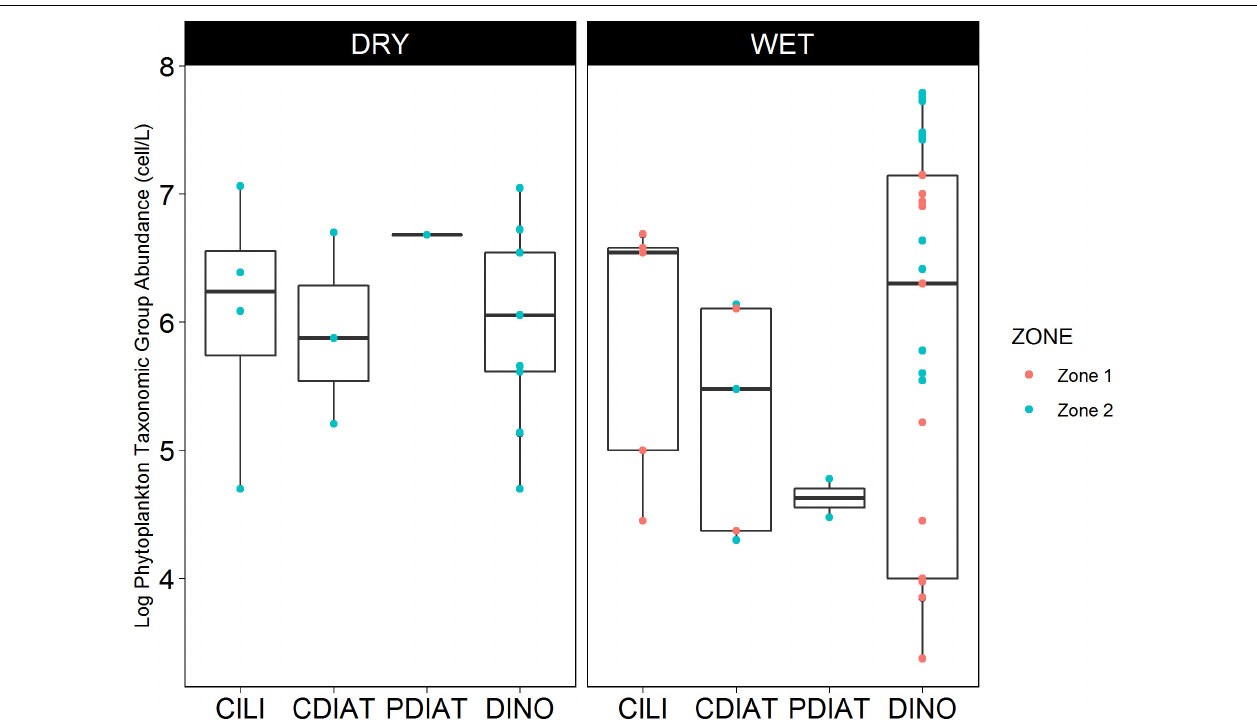
FIGURE 5 | Seasonal abundance of phytoplankton taxonomic groups during HABs events in Zones 1 and 2 of the study area.